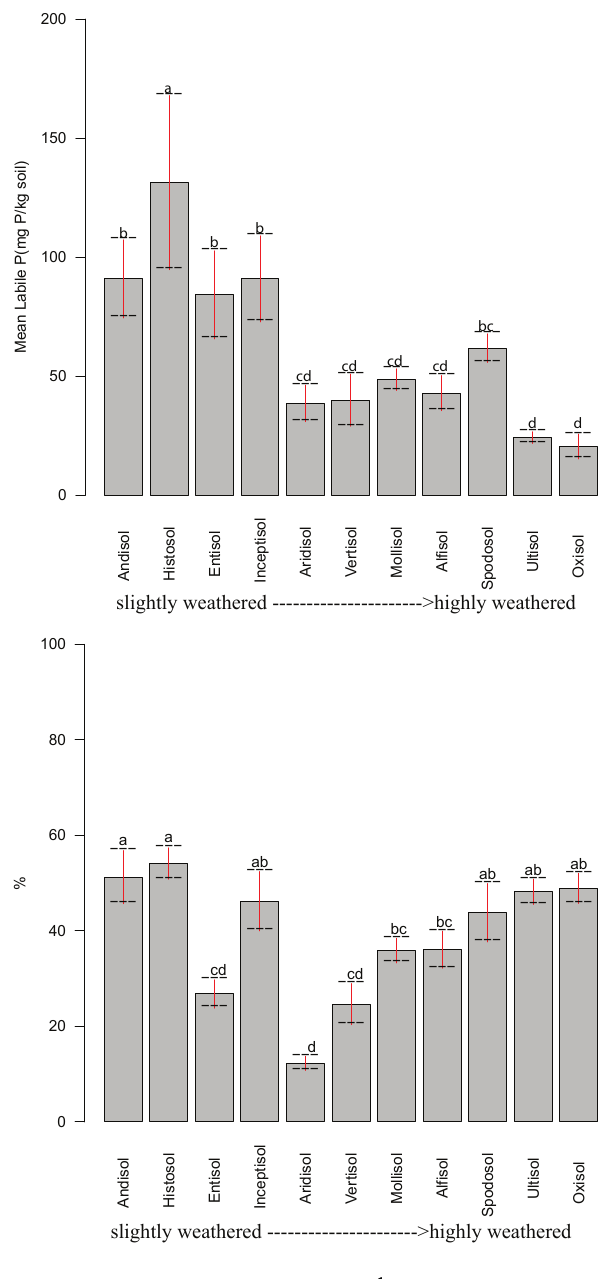
Fig. 4. (a) Mean labile P (Unit:mgPkg − 1 soil) in different soil or- ders; (b) bicarbonate Po as a percentage of labile P in different soil orders(unit: percentage). Slightly weathered soils: Andisols, His- tosols, Entisols, Inceptisols; Intermediately weathered soils: Aridis- ols, Vertisols, Mollisols, Alfisols; Highly weathered soils: Ultisols, Spodosol, Oxisols.